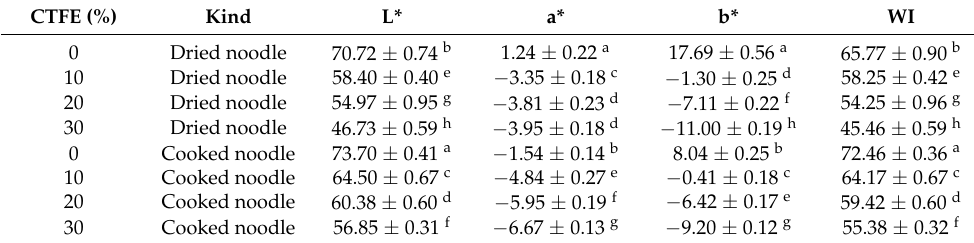
Figure 3. Appearances of dried noodle ( upper ) and cooked noodle ( lower ) fortified with 0, 10, 20, and 30% CTFE, respectively (from left to right ). Table 1. The color parameters of noodles fortified with different CTFE levels.